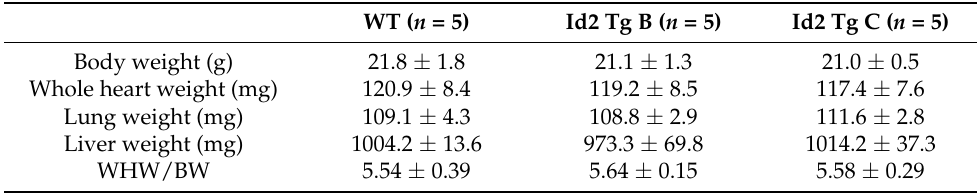
Table 1. Physiological characteristics in transgenic mice at baseline.